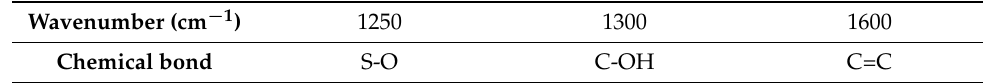
Figure 4. FTIR spectra of sGO and S-1. Table 2. Detected signals in the FTIR